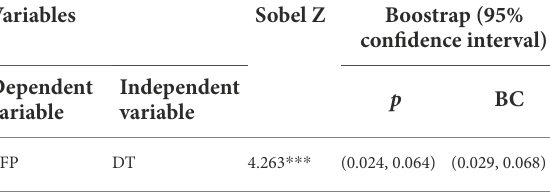
TABLE 5 The results of the Sobel and bootstrap test.